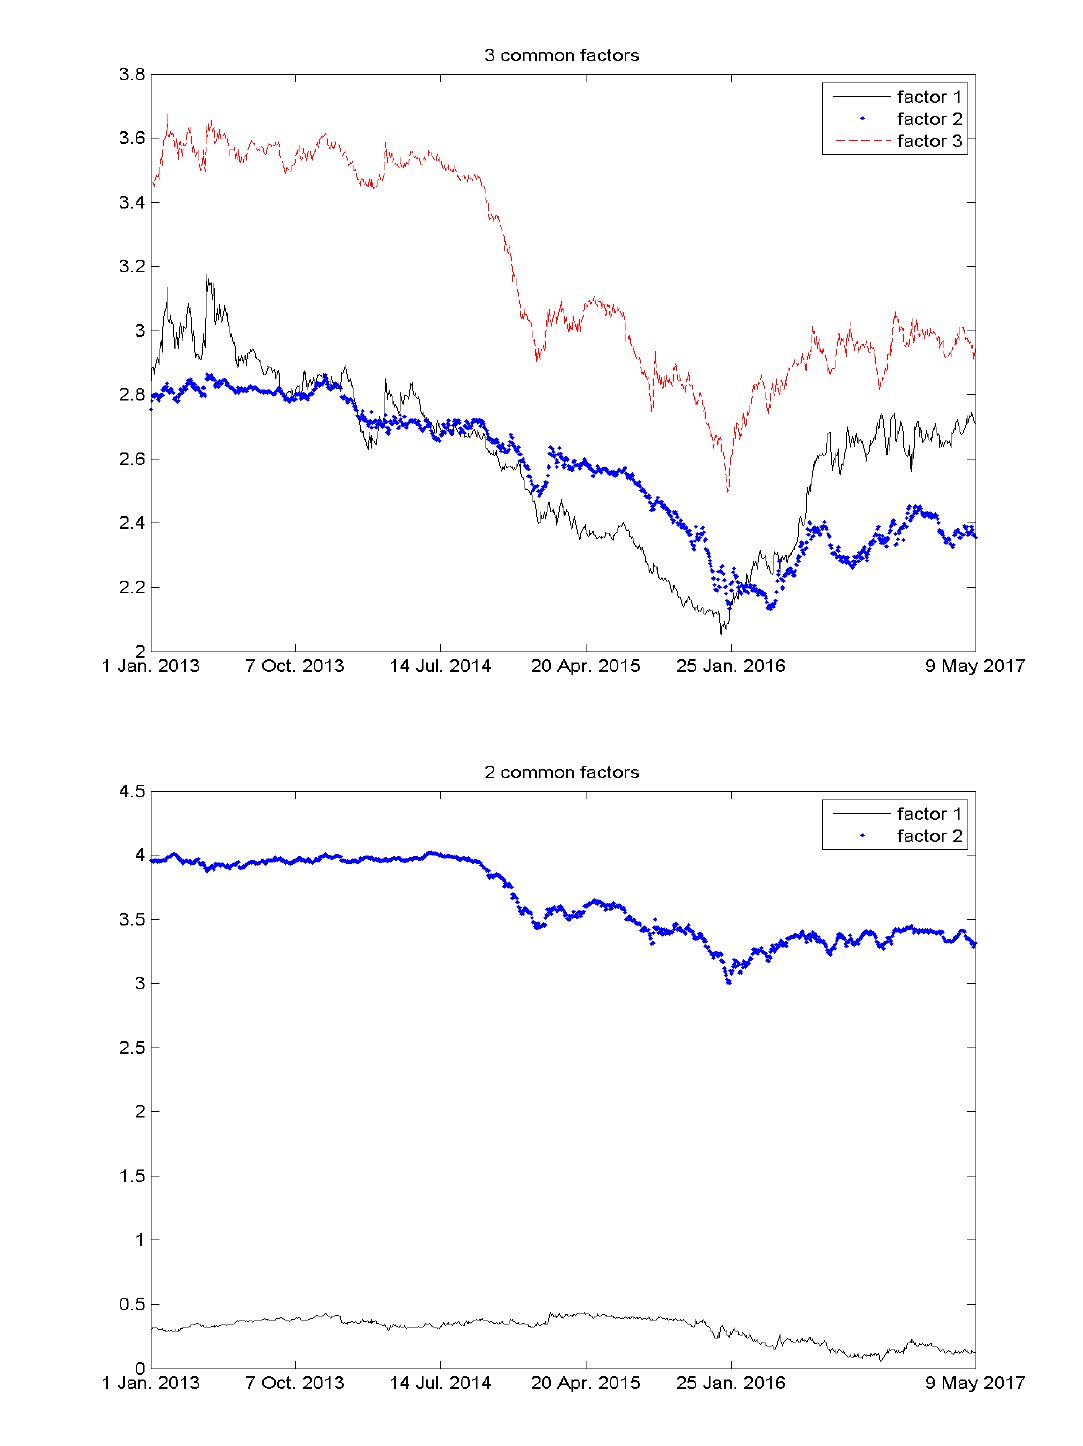
Figure 1. Common trends obtained from the Gonzalo–Granger permanent-transitory decomposition using daily data from January 2013–May 2017. Top panel for EUA, coal, gas and Brent oil and bottom panel for coal, gas and Brent